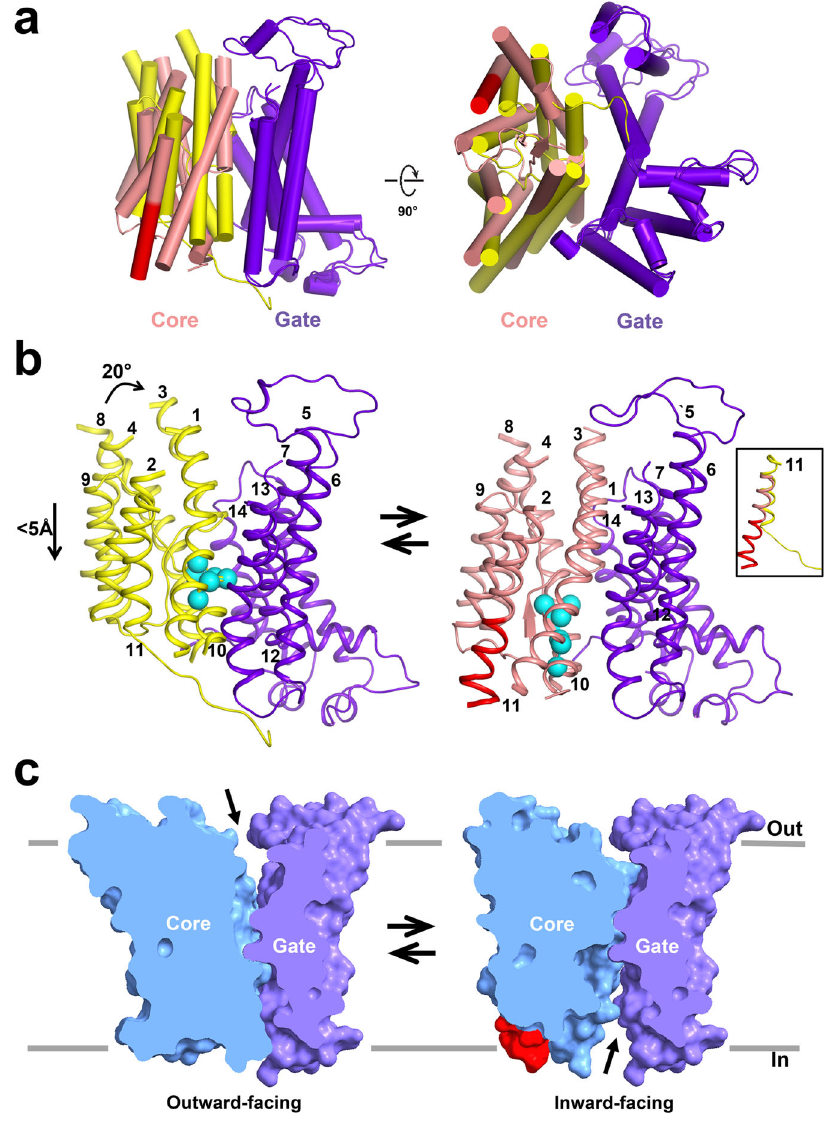
Fig. 3 Comparison of OF and IF states of bovine AE1. a Superposed atomic models of OF and IF states showing signi fi cant conformational rearrangements of the core domain. In the IF state, TM11 extends signi fi cantly (red cylinder). Gate domain (purple), IF core domain (salmon) and OF core domain (yellow). b Comparison of OF and IF states of AE1 demonstrating downward movement with some rotational motion of the core domain with respect to the gate domain during the OF to IF transition (see also Supplementary Movies 1 – 3). C α atoms of previously identi fi ed core residues from the central S1 site 27 are shown as cyan spheres. The inset illustrates the difference in TM11 in the OF and IF state. c Surface models of the OF and IF structures. The OF and IF cavities are indicated with